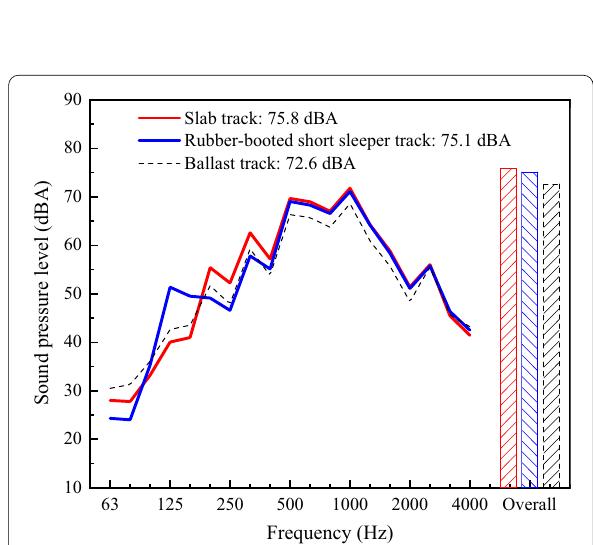
Figure 17 Interior noises under different track structures